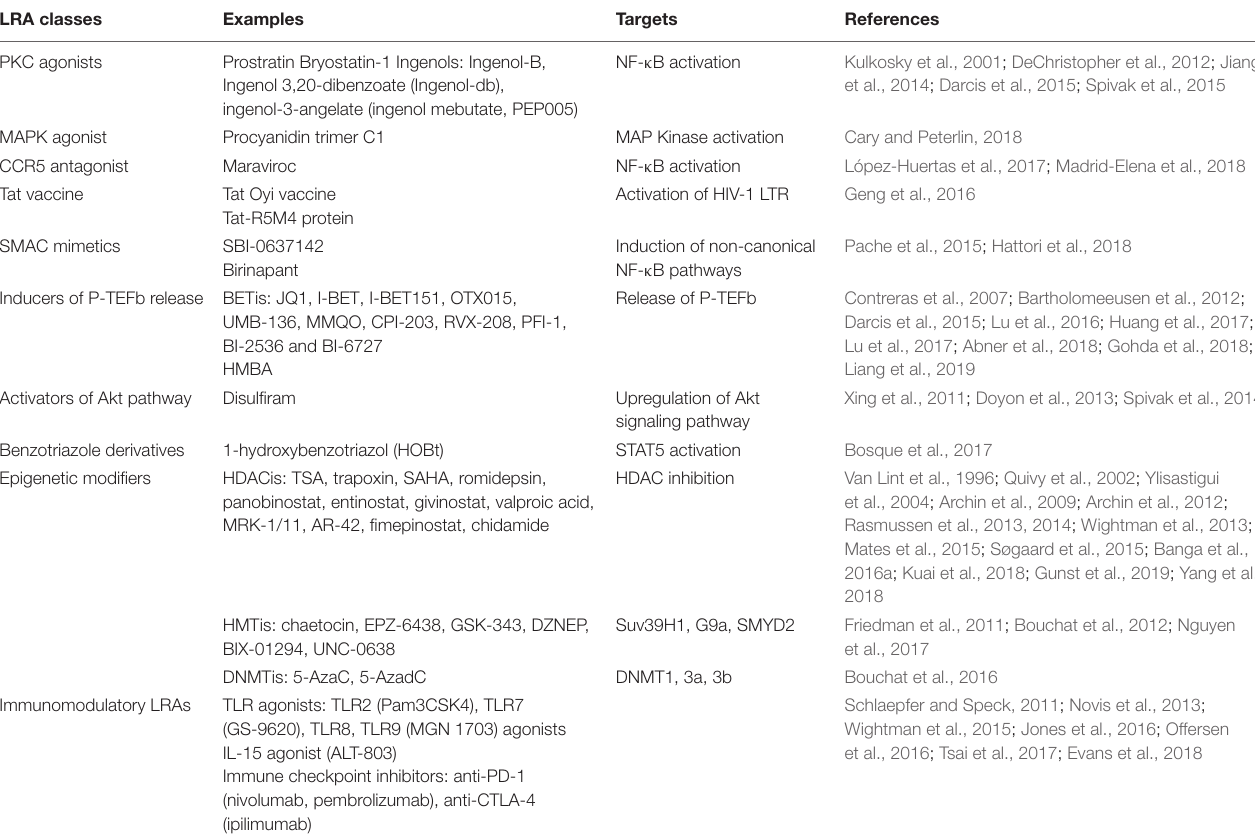
TABLE 1 | Classes of HIV-1 latency reversing